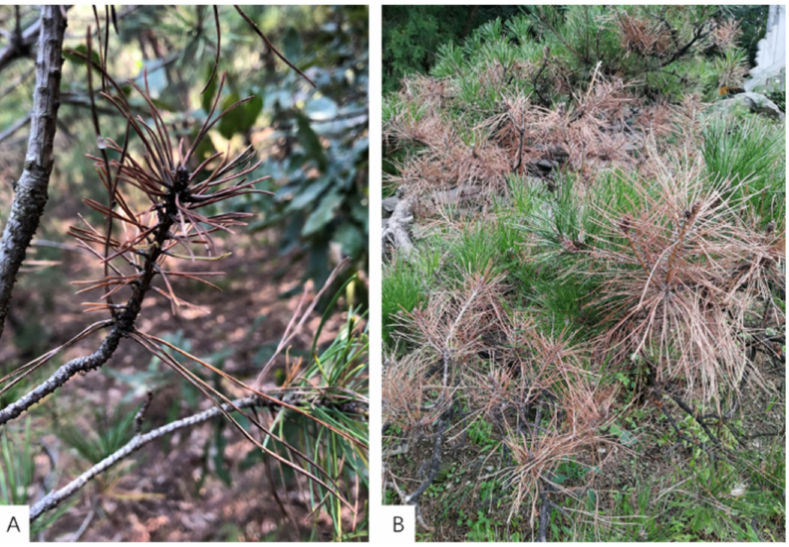
Figure 1. Symptoms of local ( A ) and overall ( B ) tip blight in Pinus densiflora caused by Sphaeropsis sapinea